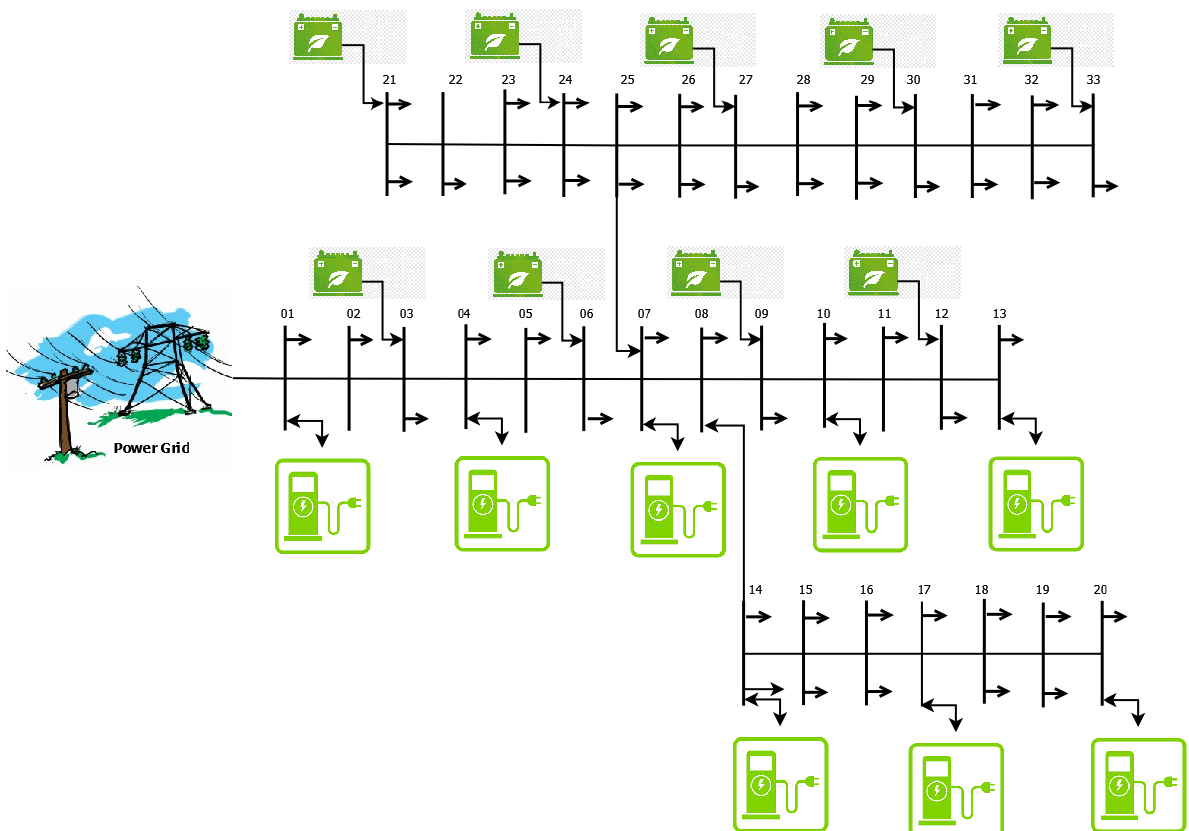
Figure 2. EV Charging Stations with 33-bus Distribution